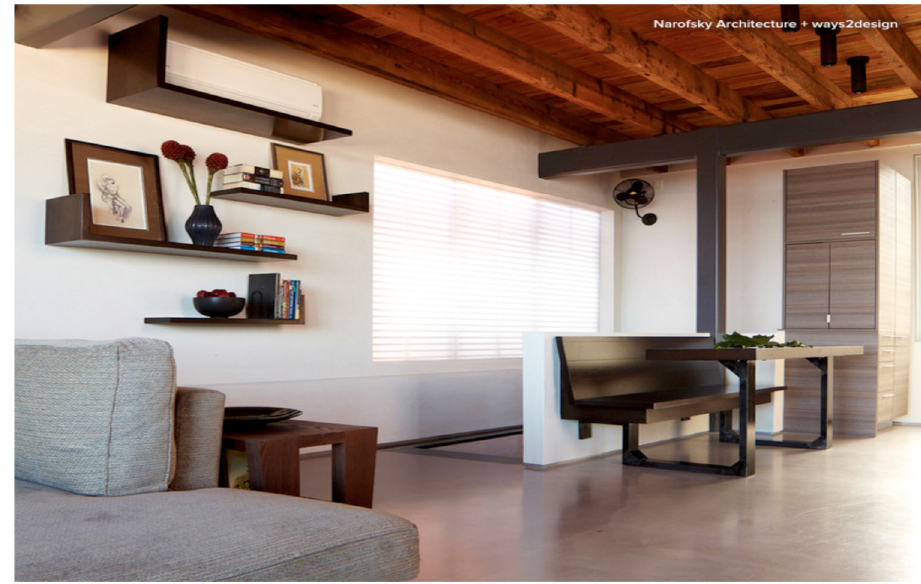
Fig. 3. Air conditioner integrated as a decorative